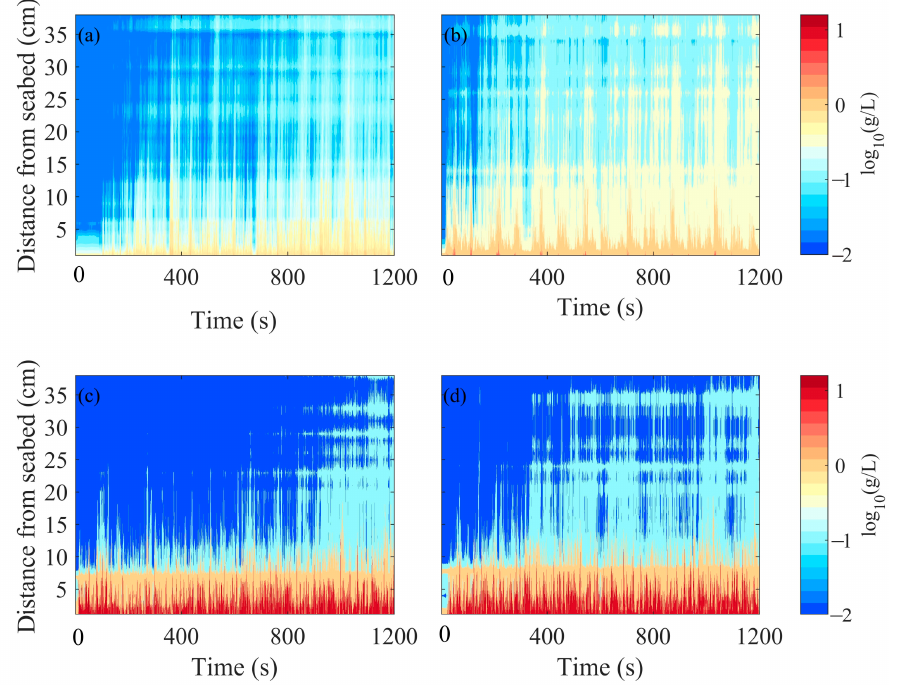
Figure 8. Response of SSC impacted by the waves: ( a , b ) represent experiments II-3 and II-4, with effective wave heights of 16 cm and 18 cm, respectively, depicting the SSC response of nonliquefied seabed; ( c , d ) represent experiments IV-2 and IV-3, with effective wave heights of 16 cm and 18 cm, respectively, depicting the SSC response of liquefied seabed.